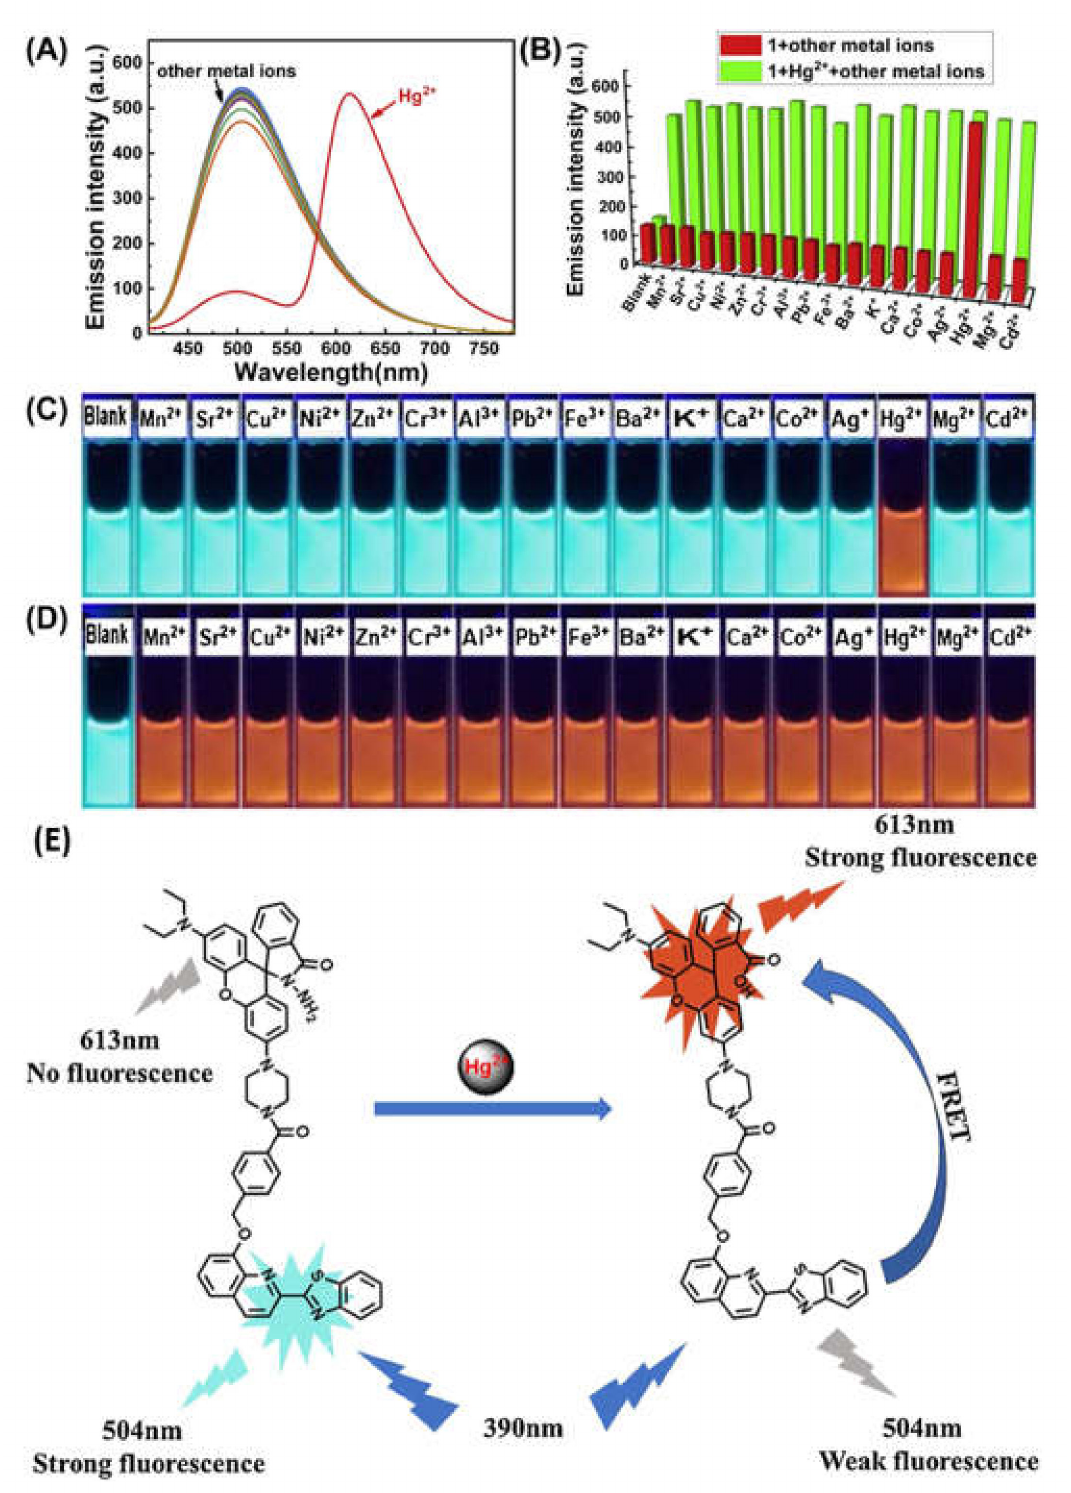
Figure 16. ( A ) Fluorescence responses of 47 (1 in image represents sensor 47) (10 µ M) in the presence of various metal ions; ( B ) Fluorescence intensity at 613 nm of 47 (red bars: 47 with other metal ions, green bars: 47 with other metal ions and Hg 2+ , λ ex = 390 nm). ( C ) The color image of 47 (10 µ M) with other metal ions. ( D ) The fluorescence photo of 47 (10 µ M) upon addition Hg 2+ (20 eq.) in the existence of other metal ions (20 eq.). ( E ) The FRET process of 47 detecting Hg 2+ . Reproduced with permission from [76]. Copyright 2020